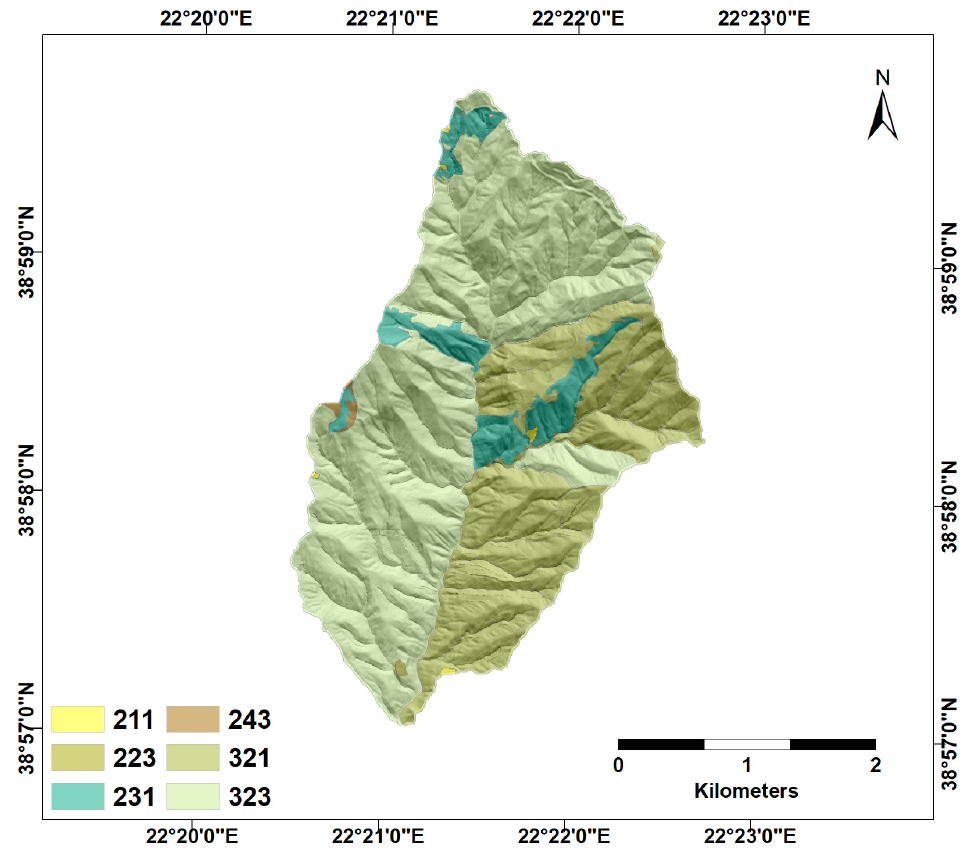
Figure5 Figure 5. Land use classification of the Platana Dam basin (see Table 4 for code